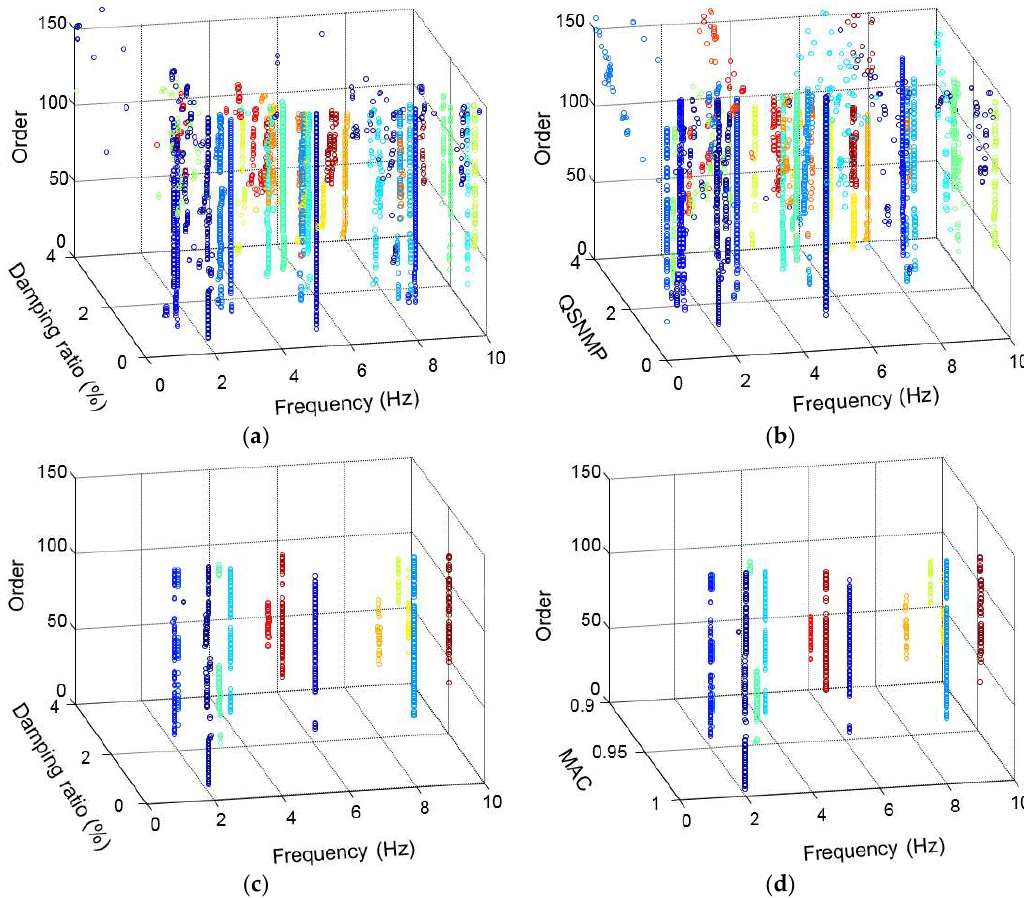
Figure 5. 3D stabilization diagram, created by applying the DBSCAN algorithm: ( a ) poles with different damping ratios, after applying the DBSCAN only based on frequency; ( b ) poles with different QSNMPs, after applying the DBSCAN only based on frequency; ( c ) poles after applying the DBSCAN, based on both the modal frequency and damping ratio; ( d ) poles after applying the DBSCAN, based on the modal frequency, damping, and mode shape.